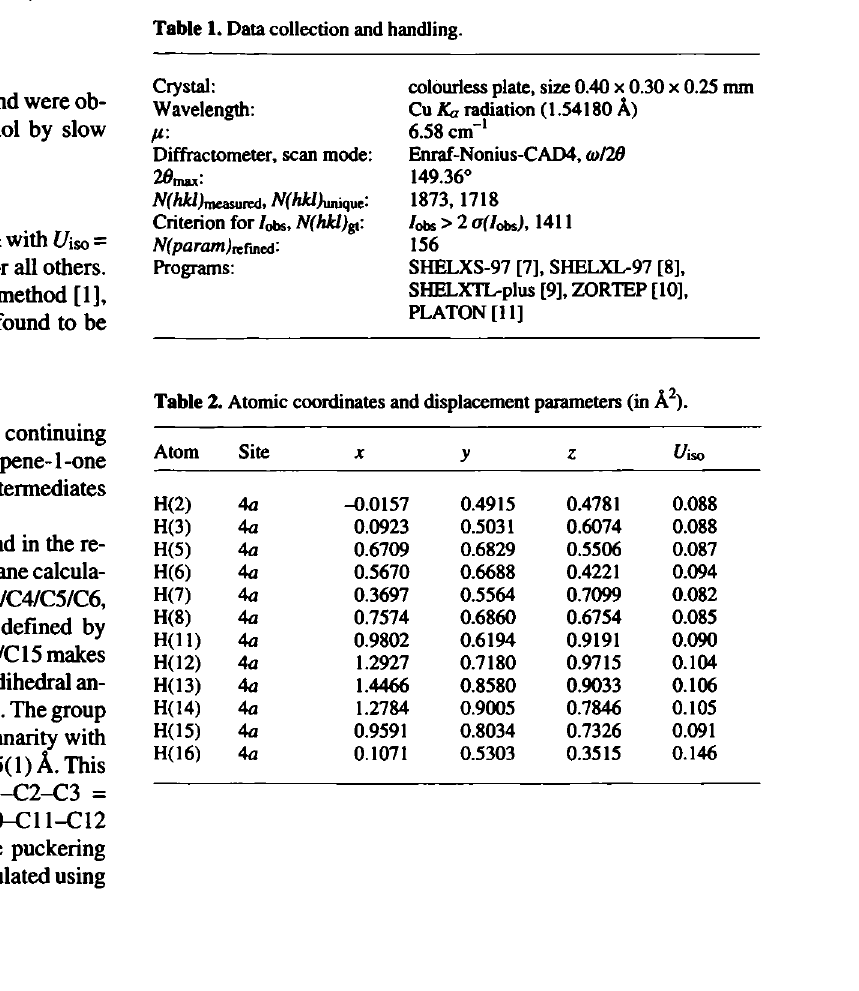
Table 1. Data collection and handling.